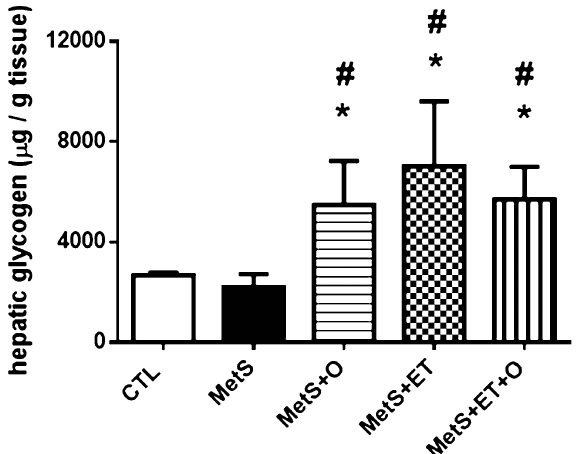
Figure 4. Analysis of hepatic glycogen. CTL–Control, MetS–Metabolic Syndrome, MetS+O–Metabolic Syndrome and Okra, MetS+ET–Metabolic Syndrome and Exercise Training, MetS+ET+O–Metabolic Syndrome and Exercise Training and Okra. *Different from CTL, #Diiferent from MetS. p ≤